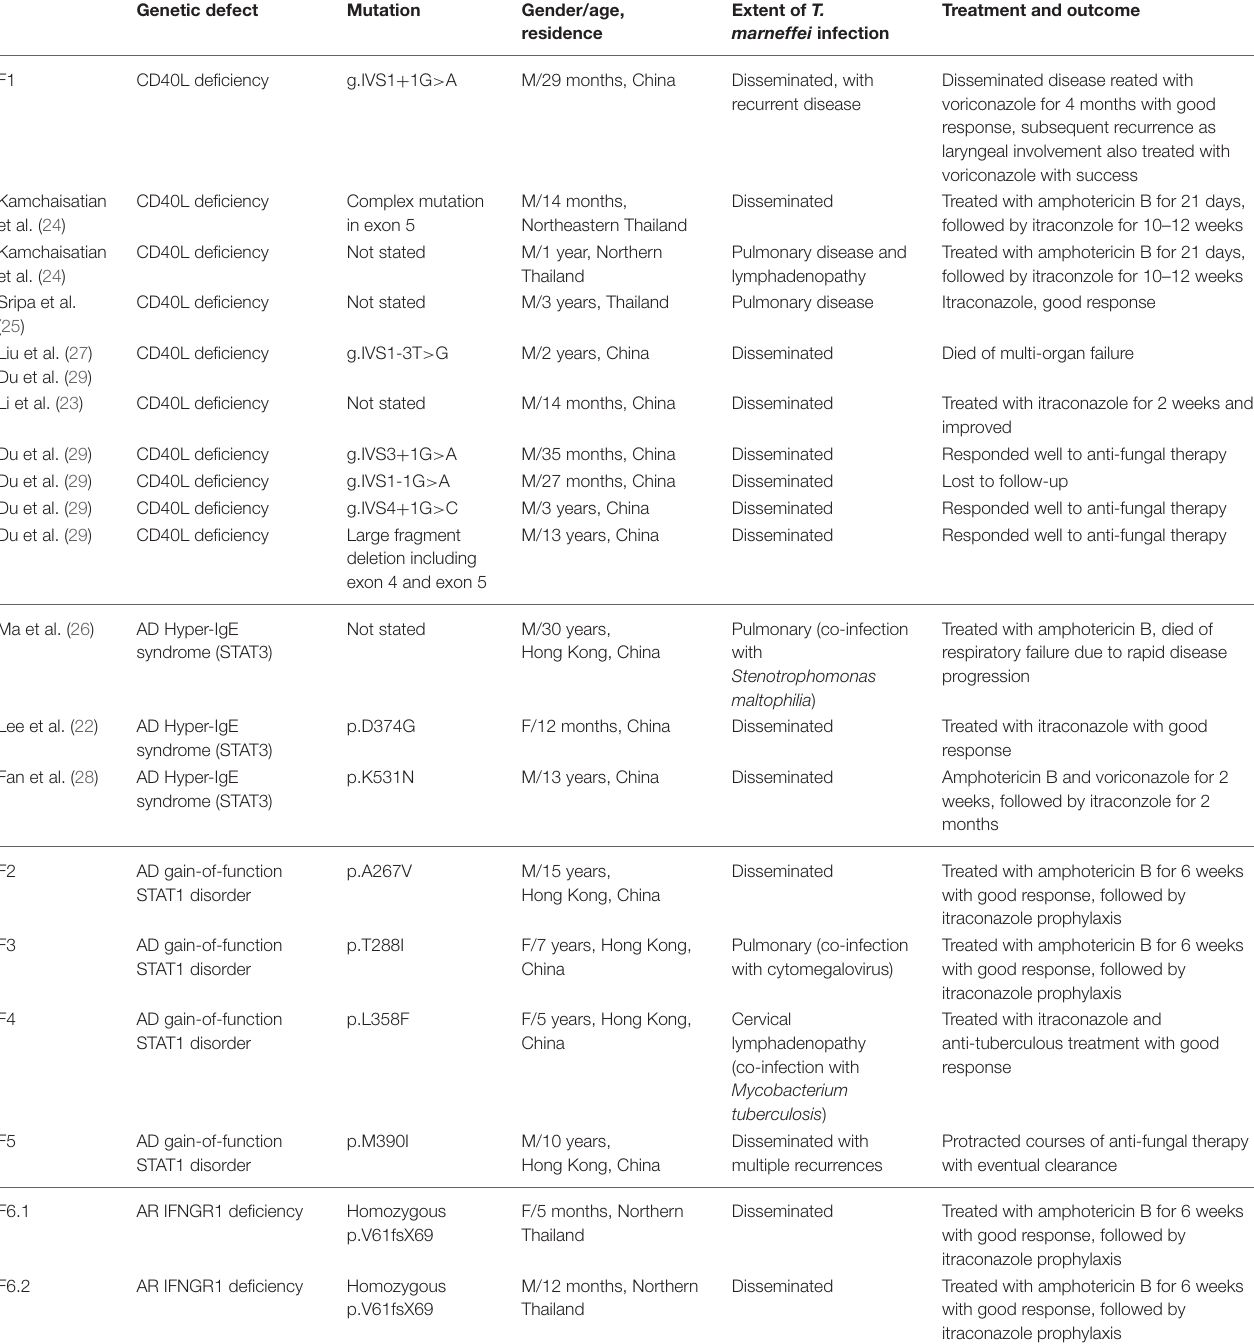
TABLE 2 | Primary Immunodeficiencies reported in HIV-negative children with T. marneffei